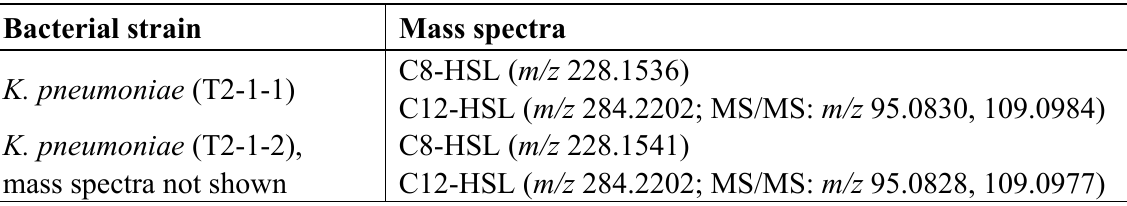
Table 2. MS analyses of AHLs in the extracts of spent culture supernatants from oral K. pneumoniae